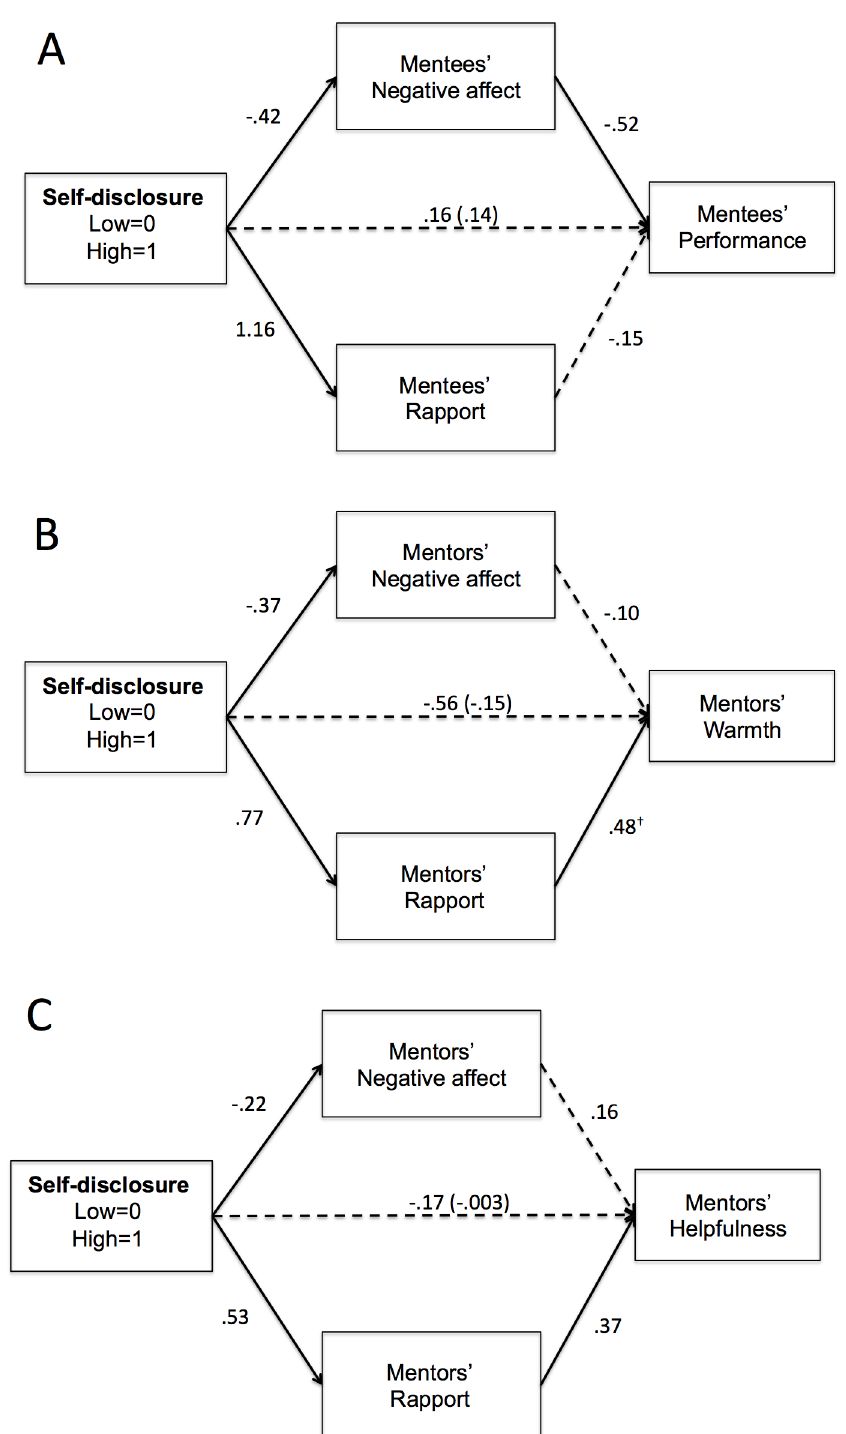
Fig 4. Path model predicting A: Mentees’ speech performance, B: Mentors’ feedback warmth, and C: Mentors’ feedback helpfulness. Solid lines indicate significant paths. Dashed lines indicate non-significant paths. Coefficients are unstandardized. Parenthetical number indicates total effect